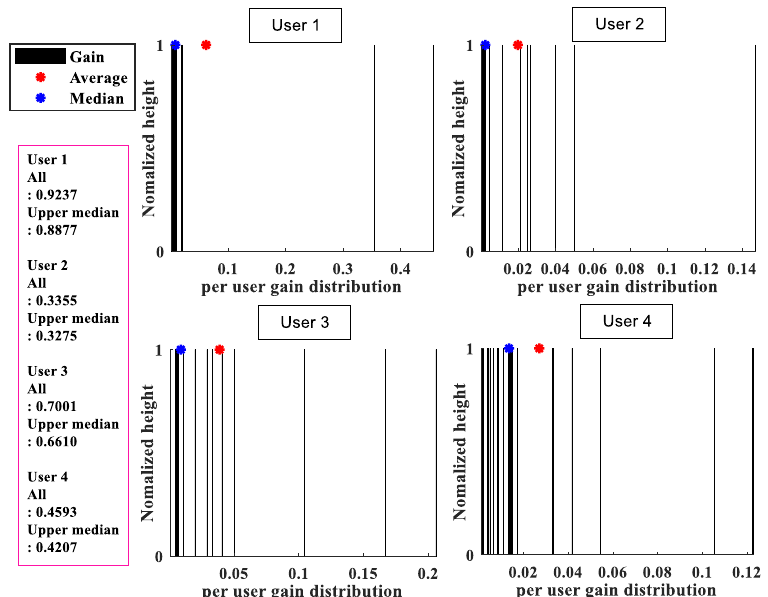
Figure 2. Distribution of per-user throughput for four users.